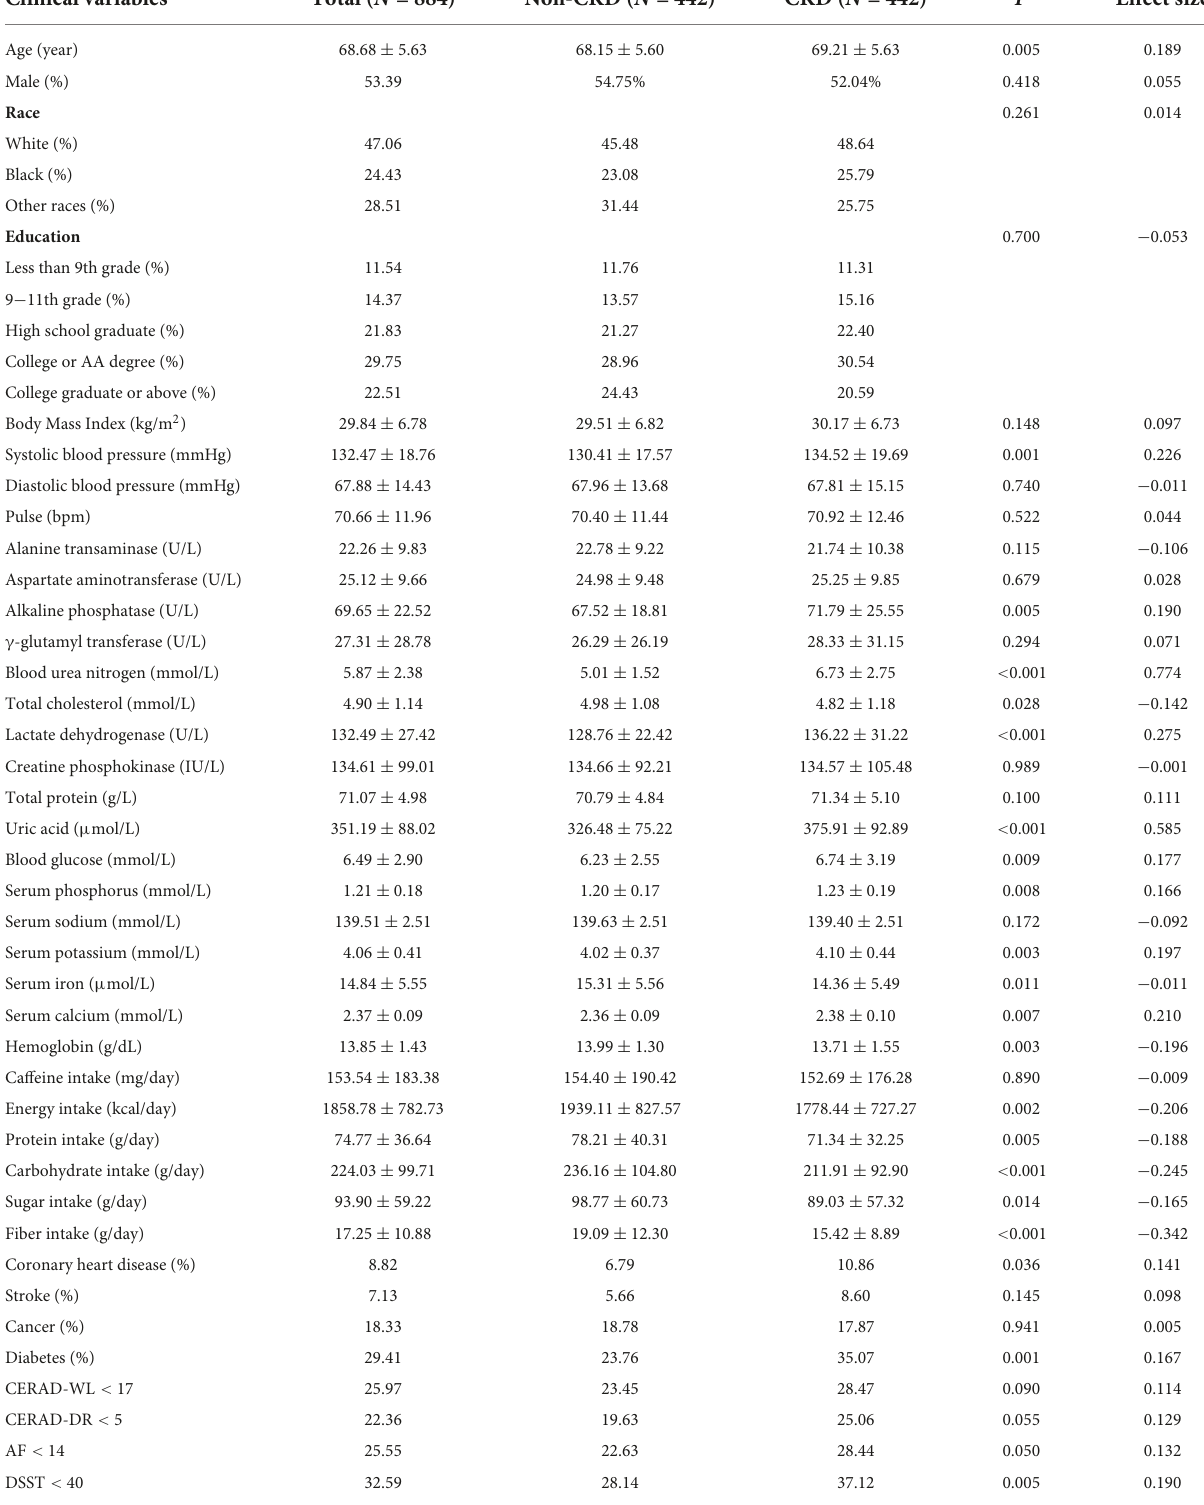
TABLE 1 Clinical characteristics of subjects in National Health and Nutrition Examination Survey (NHANES) 2011 − 2014. Clinical